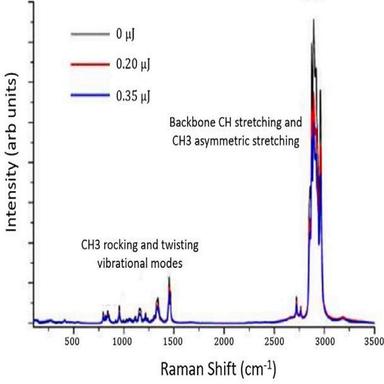
Photo of 5 × 5×7 mm bulky gratings.